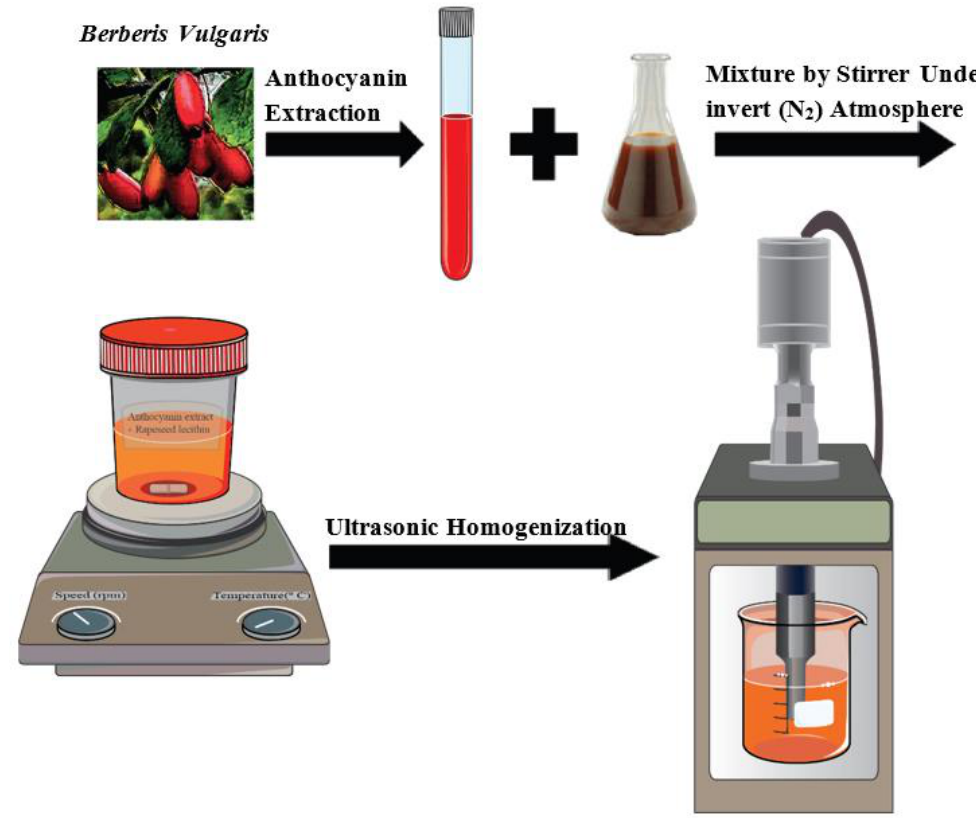
Figure 1. Schematic illustration of preparation of anthocyanin compounds (AC) incorporated in rapeseed nanoliposome.